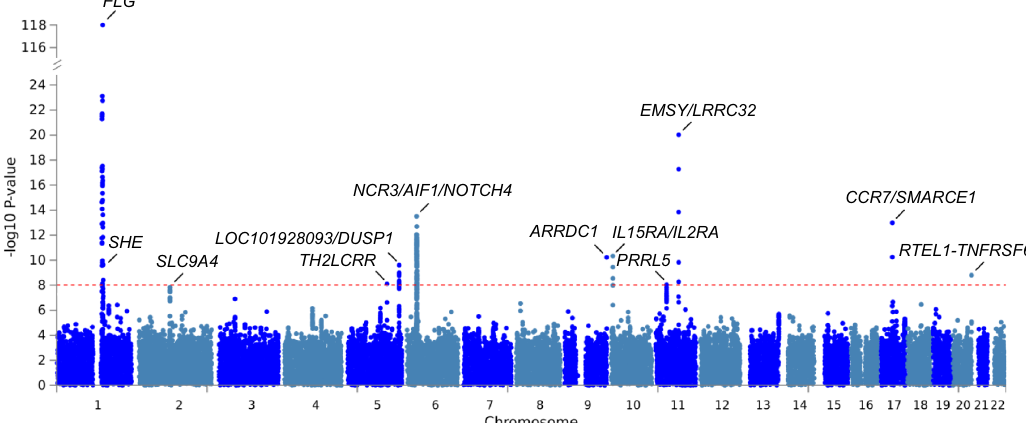
Fig. 2 Manhattan plot of the meta-GWAS results on rare variants in eczema at the single SNP level. Meta-analysis results for all variants with a minor allele frequency < 5% are shown. For each SNP (dots), the genomic location ( x -axis) and the association P value ( y -axis) are indicated. The red line corresponds to the genome-wide signi fi cance threshold of 1 × 10 − 8